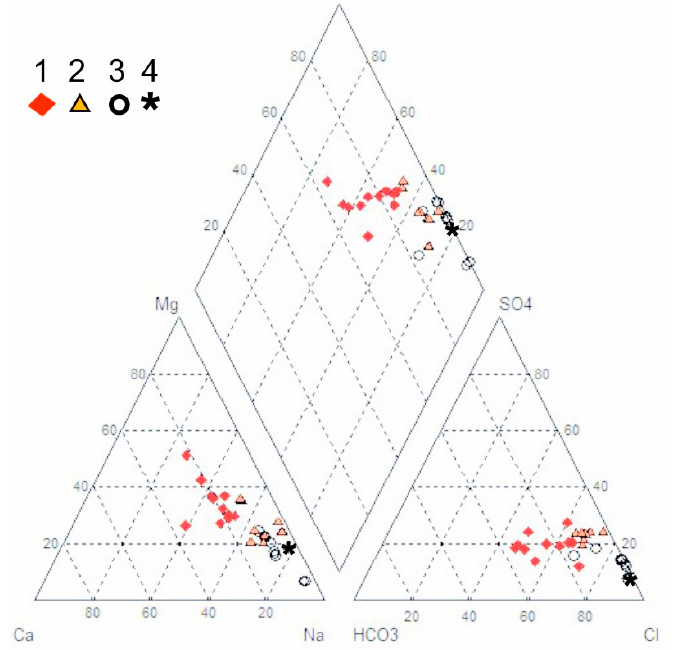
Figure 7. Piper diagram of hydrochemical data. 1: shallow aquifer; 2: Balsa del Sapo; 3: Punta Entinas; 4: sea water. Point location in Figure 1a. Balsa del Sapo data from [25].